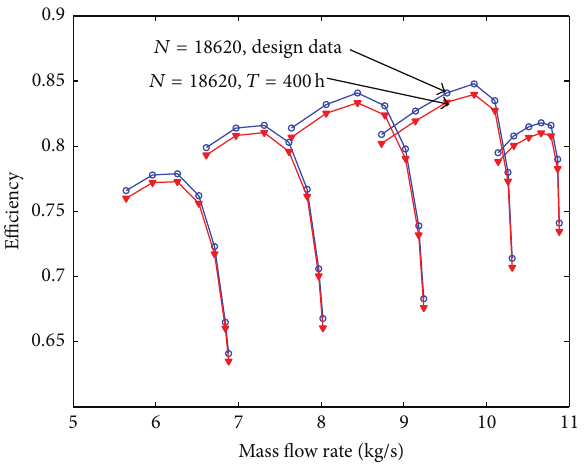
Figure 14: The efficiency curve with 400 hours due to fouling with different relative fouling severity coefficient.